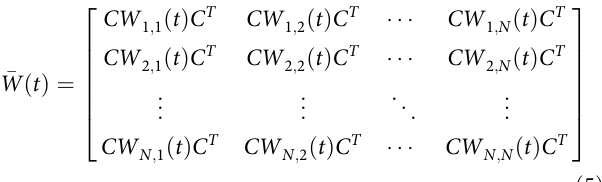
Fig. 2 An outline of the method in terms of composite matrices ~ A and ~ B